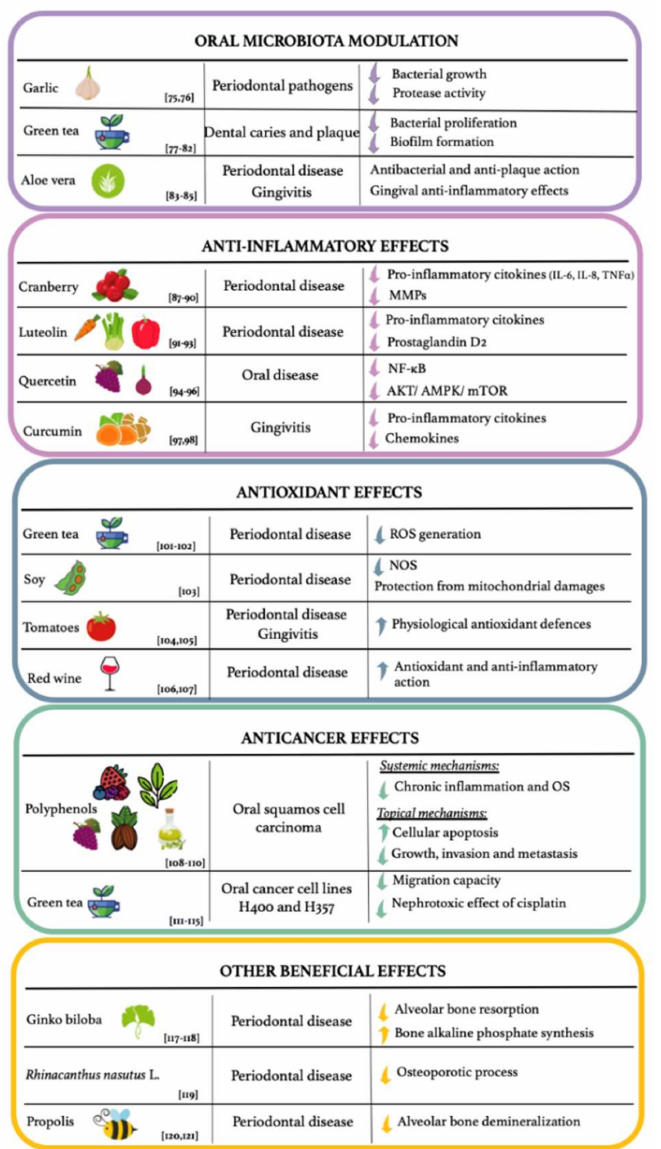
Figure 3. Possible beneficial effects of natural bioactive compounds on oral diseases in chronic kidney disease patients. Abbreviations: AKT, protein kinase B; AMPK, AMP-activated protein kinase; IL-6, interleukin-6; IL-8, interleukin-8; MMPs, matrix metalloproteinases; mTOR, mammalian target of rapamycin; NF- κ B, nuclear factor- κ B; NOS, nitric oxide synthase; OS, oxidative stress; ROS, reactive oxygen species; TNF- α , tumor necrosis factor α